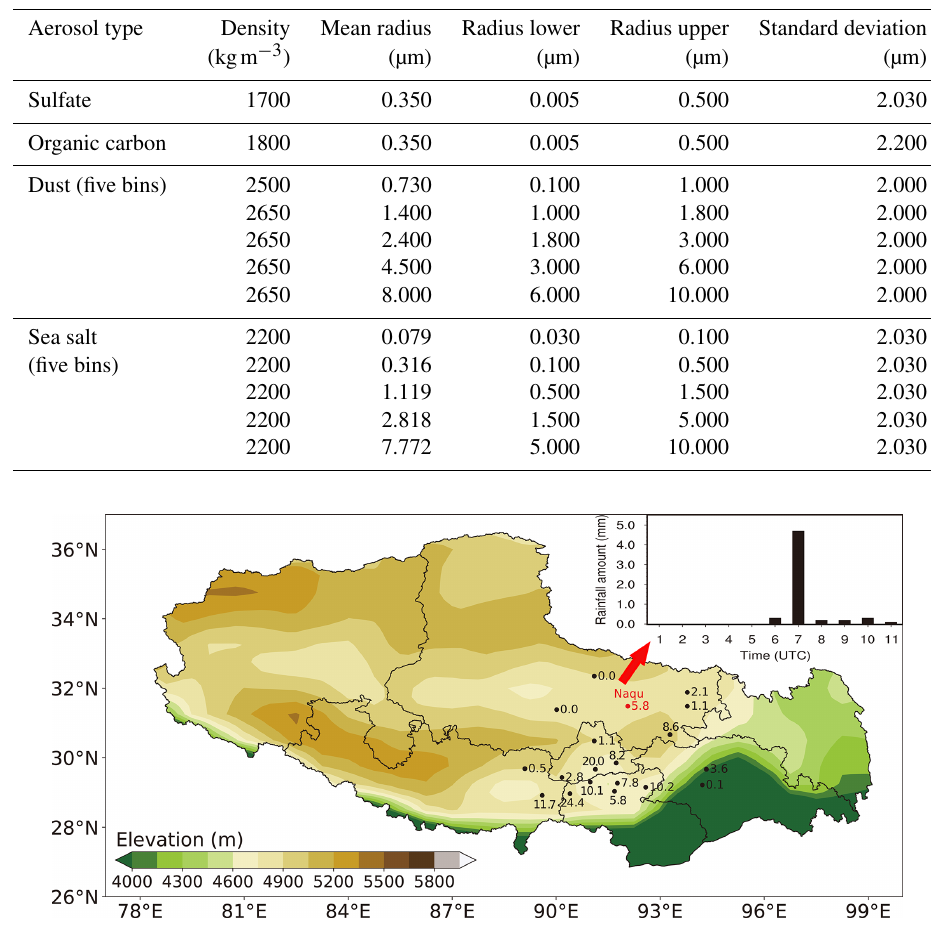
Figure 1. Accumulated precipitation of 24h in Tibet and the hourly precipitation in Naqu on 24 July 2014.